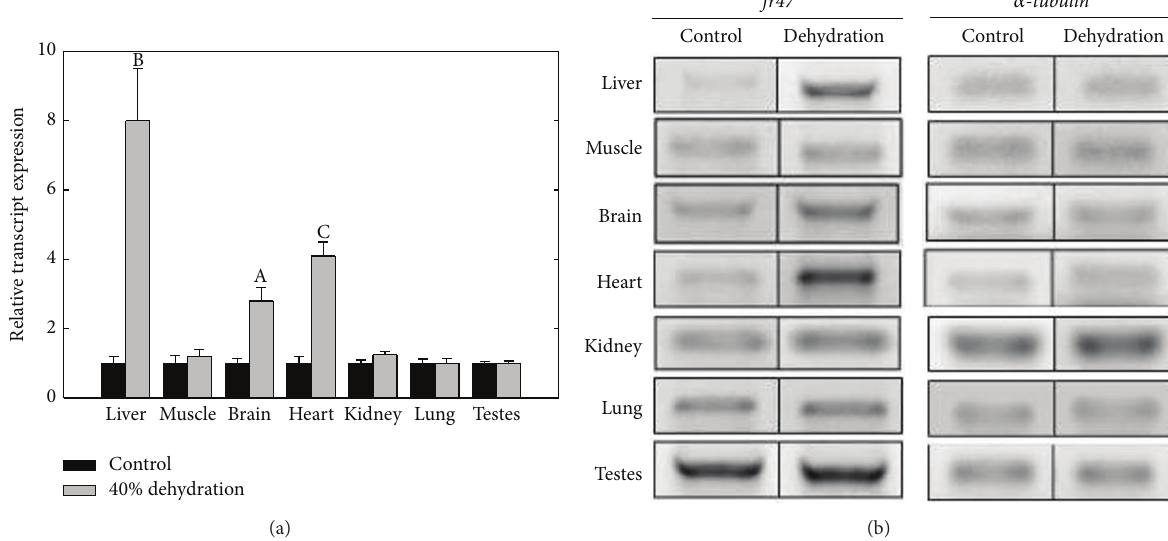
Figure 5: Relative fr47 transcript expression in response to 40% dehydration. RT-PCR analysis showing the effects of 40% dehydration on fr47 transcript levels in seven tissues of wood frogs. (a) Histogram shows mean values ( ± SEM, 𝑛 = 4 -5 independent determinations) for fr47 . (b) Representative fr47 and 𝛼 - tubulin bands used for quantification. Other information as in Figure 3.